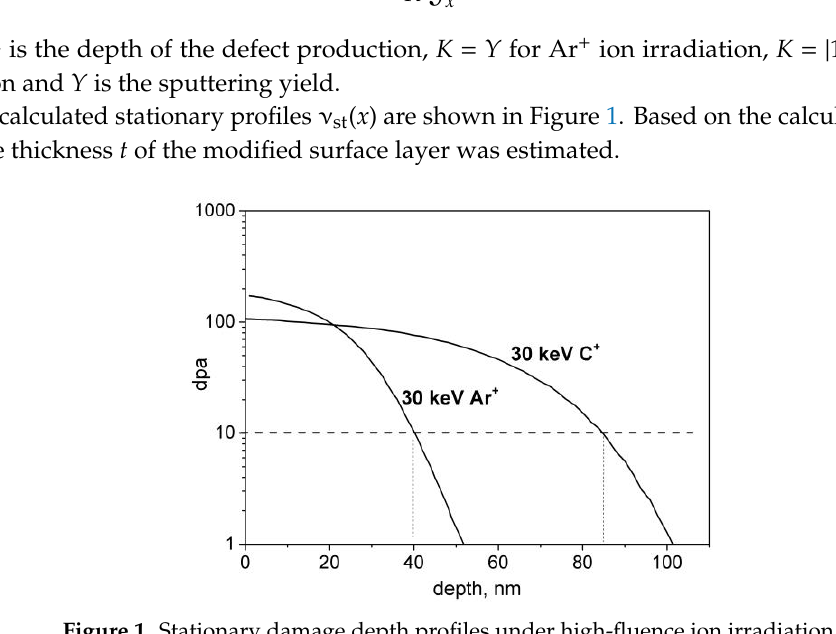
Figure 1. Stationary damage depth profiles under high-fluence ion irradiation.